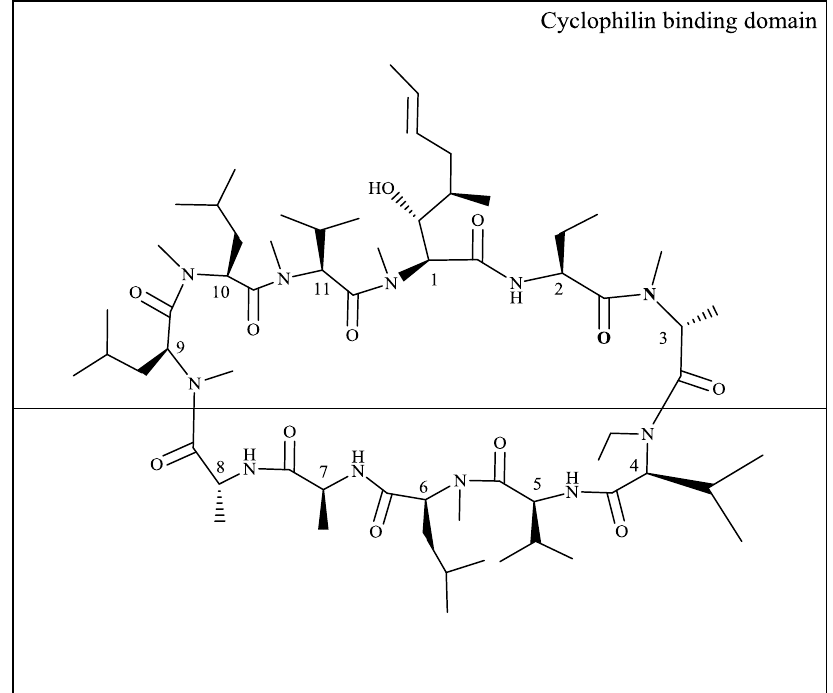
Figure 1. Structural formula of DEB025. The top part of the structure represents the cyclophilin-binding